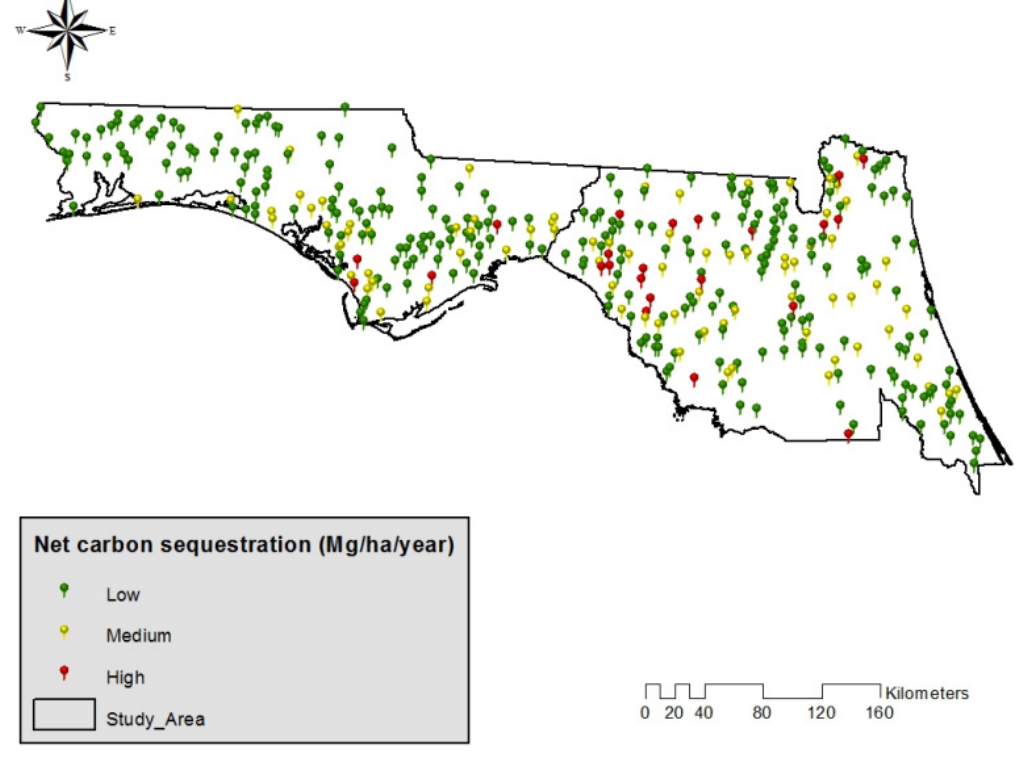
Figure 4. Net carbon sequestration rate provision levels for forest inventory analysis (FIA) Pinus elliotti plots in Florida’s northeastern and northwestern survey units, 2002–2011.